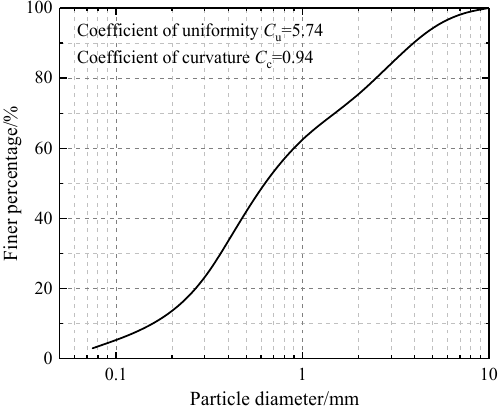
Figure 3. Gradation curve of unsaturated river sand.